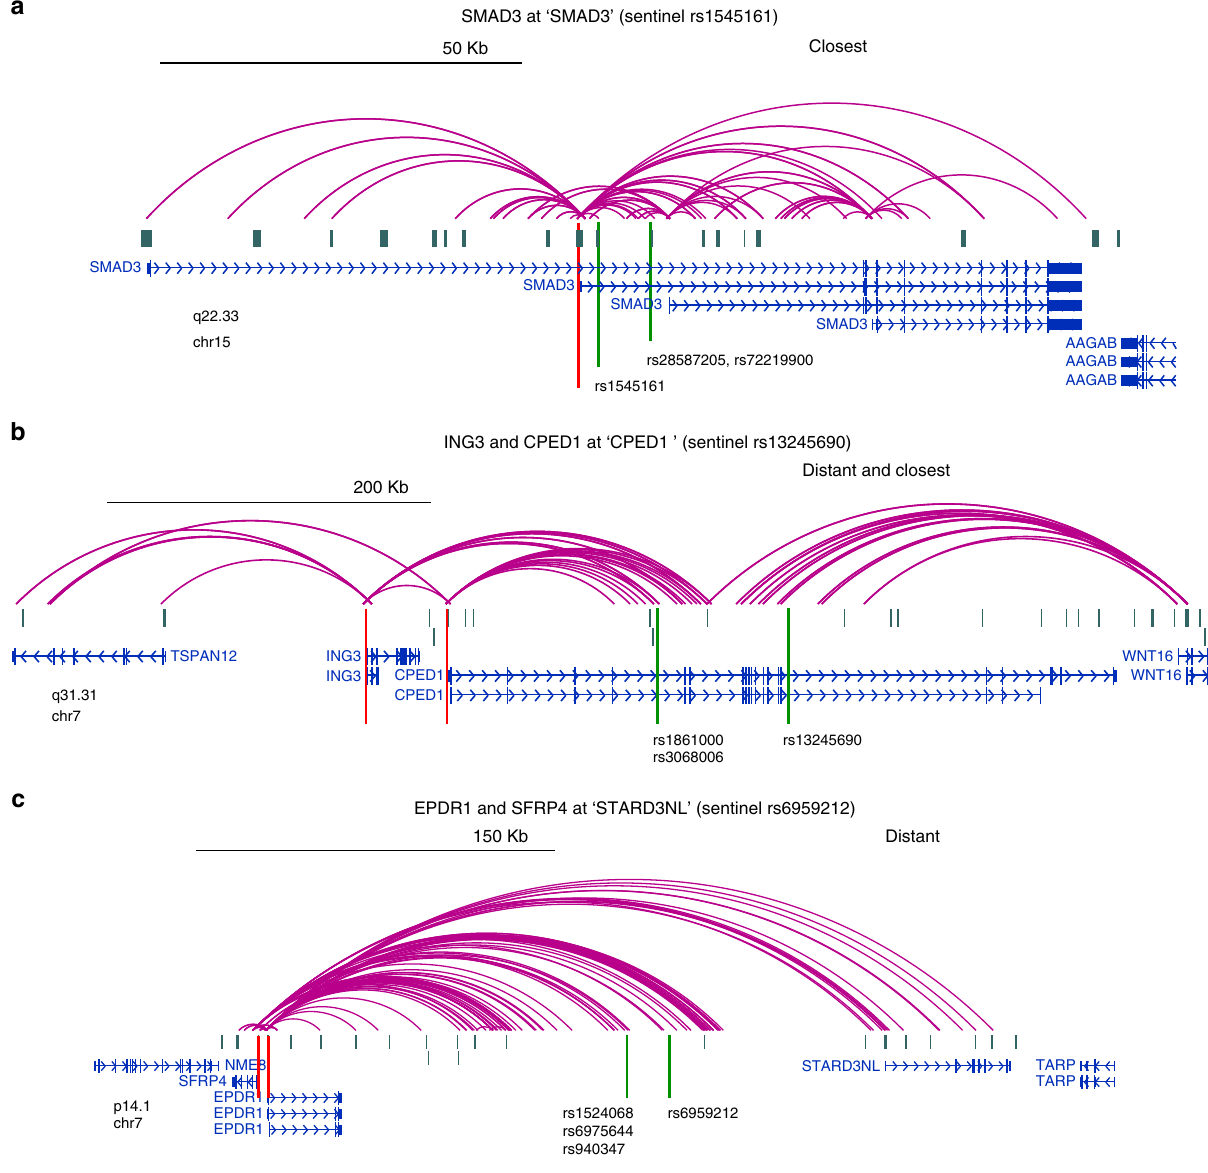
Fig. 1 Examples of interactions detected by Capture C. a to nearest gene only. b to both nearest and more distant gene(s). c only to distant gene(s). Contacts were visualized using the WashU EpiGenome Browser. Red lines indicate genes of interest, while green lines represent the sentinel and key proxy